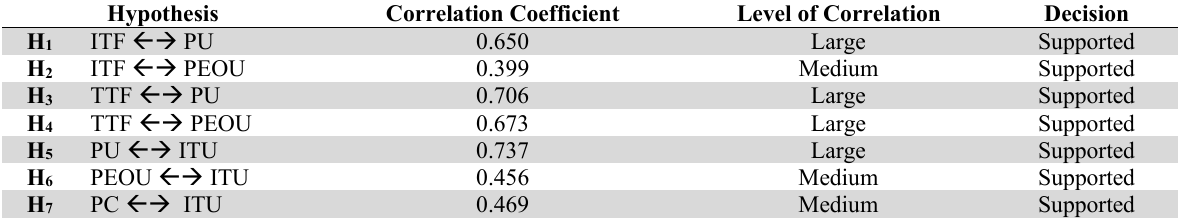
The results and summary of the proposed hypotheses